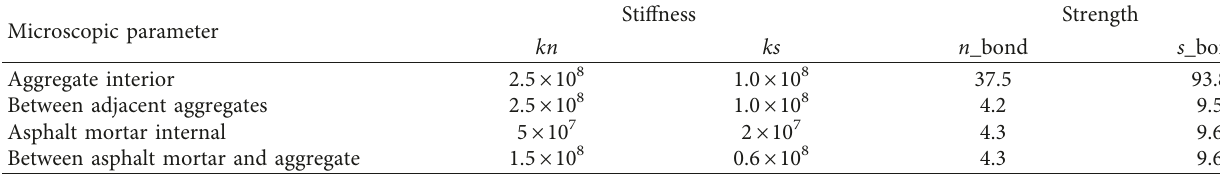
Table 8: Microscopic parameters of mixtures of SMA-13.